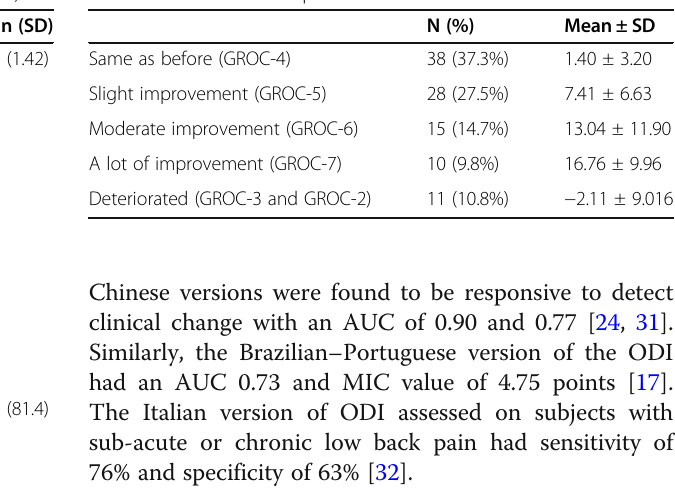
Table 3 GROC-NP